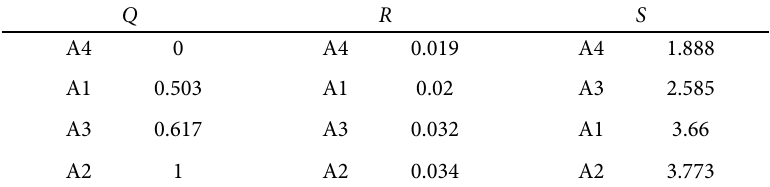
Table 6. The ranking of the states by S, R, and Q in descending